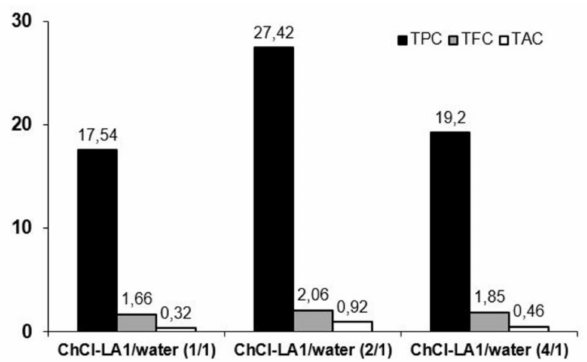
Figure 1. Total phenolic content (TPC), total flavonoid content (TFC) and total monomeric anthocyanin content (TAC) in chokeberry extracts obtained after extraction with di ff erent ChCl-LA1 aqueous solutions. TPC was expressed as mg GA g − 1 DW; TFC was expressed as mg RUT g − 1 DW; TAC was expressed as mg Cya-3-Glu g − 1